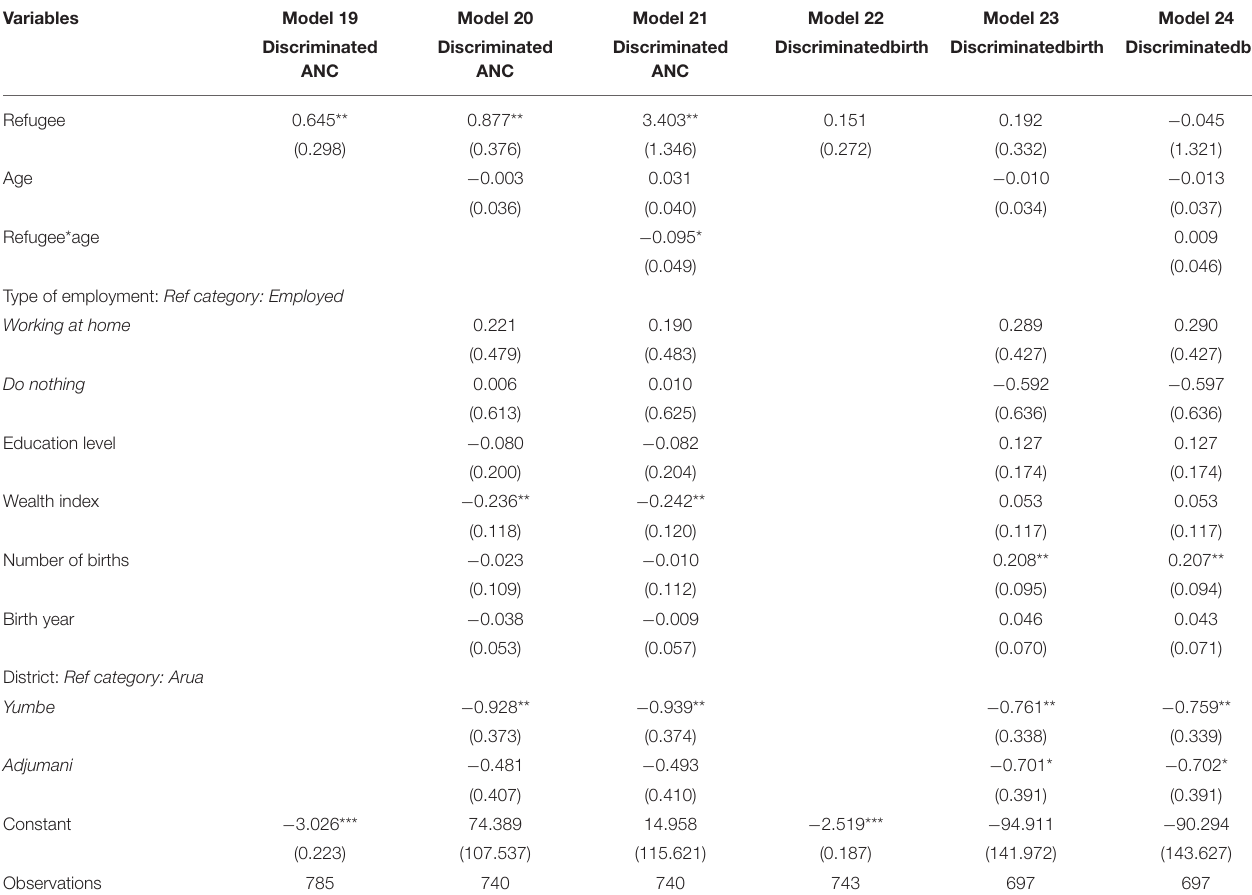
TABLE 5 | Logistic regression testing discrimination and refugee